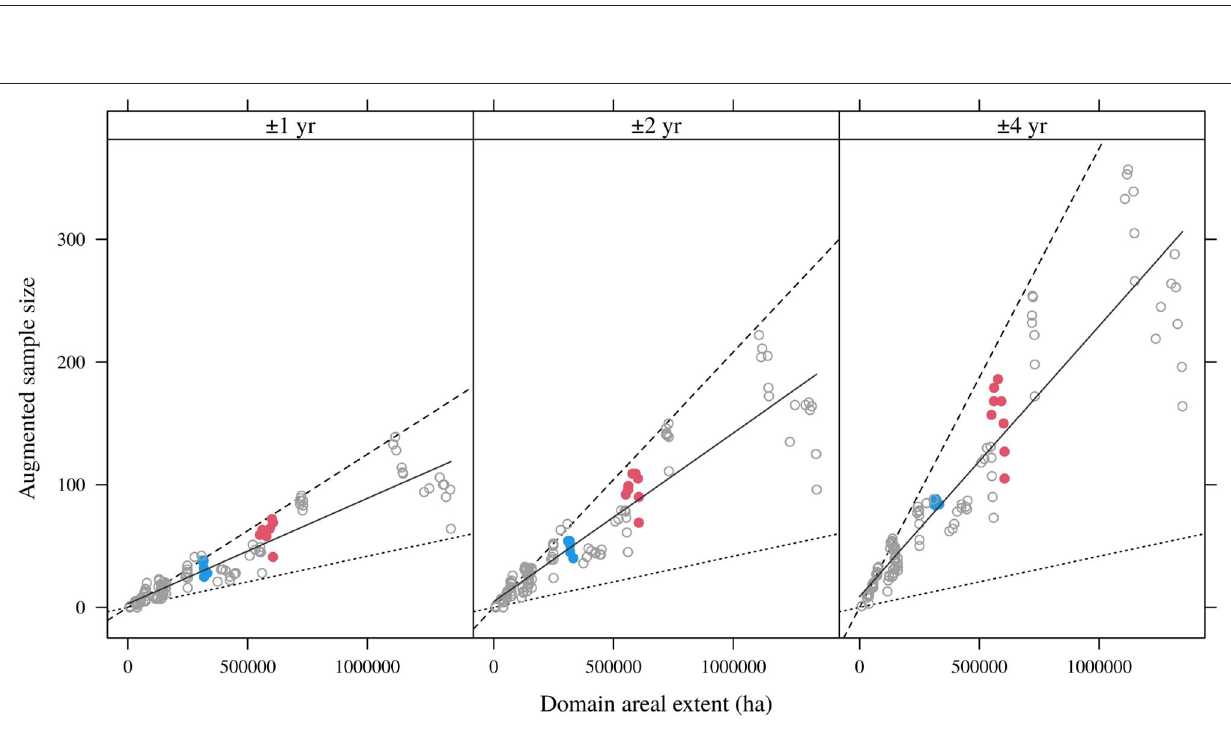
1, 2, 4 year). Dotted line is the nominal FIA = 1) r ; solid lines are linear regressions for particular burn intervals. +